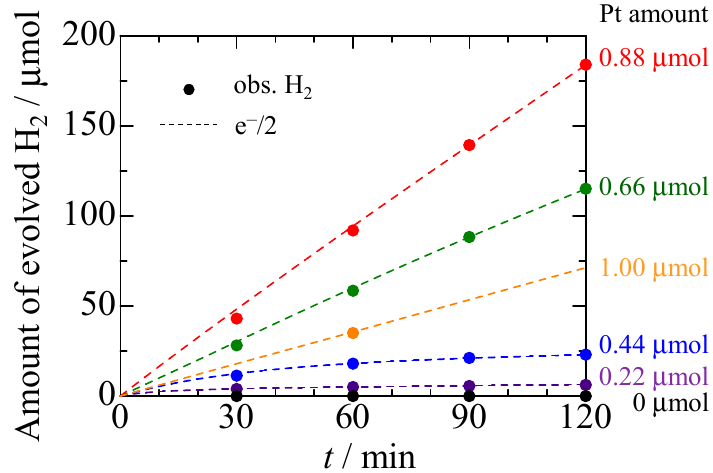
Figure 6. Time course curves of H 2 evolution (closed circles) from Pt / CdS / CuInS 2 electrodes measured at 0 V under irradiation with visible light ( λ > 420 nm). The broken lines denote time course curves of half of the electrons passing through the outer circuit (e – /2).